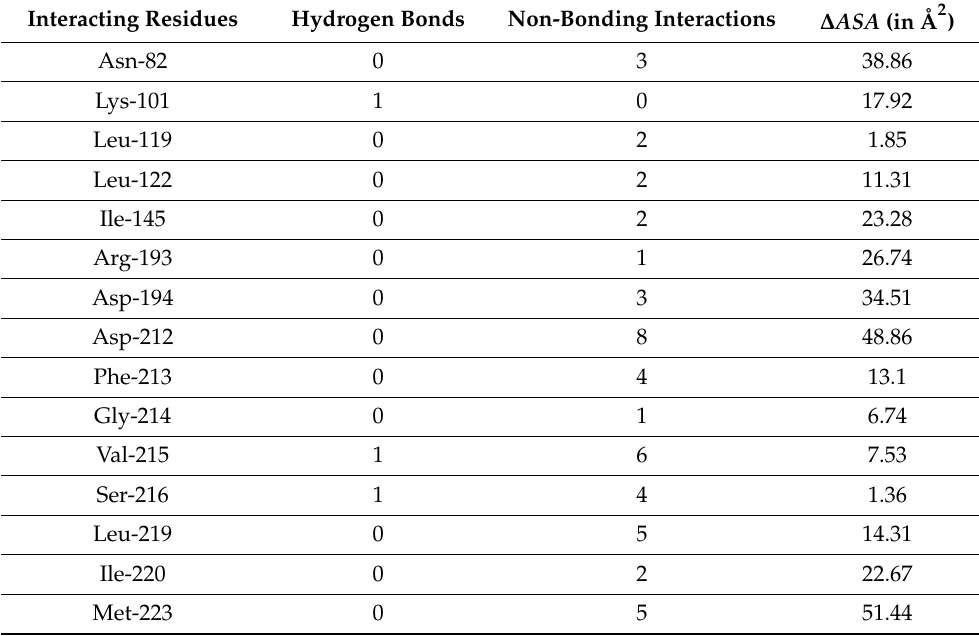
Table A3. The MEK2 residues interacting with selected flavonoid M2F3 are listed with the number of non-bonding interactions and ∆ ASA